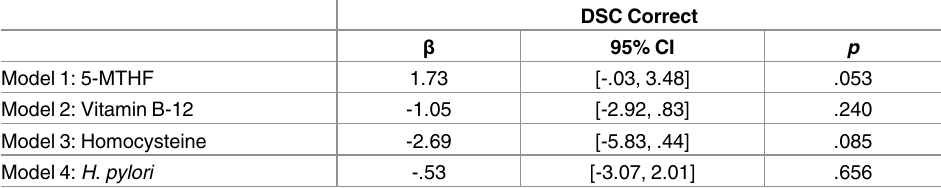
Table 2. Linear regression analysis of folate cycle factor concentrations and Helicobacter pylori infection status predicting cognitive function in U.S. 60 to 85-year-olds.